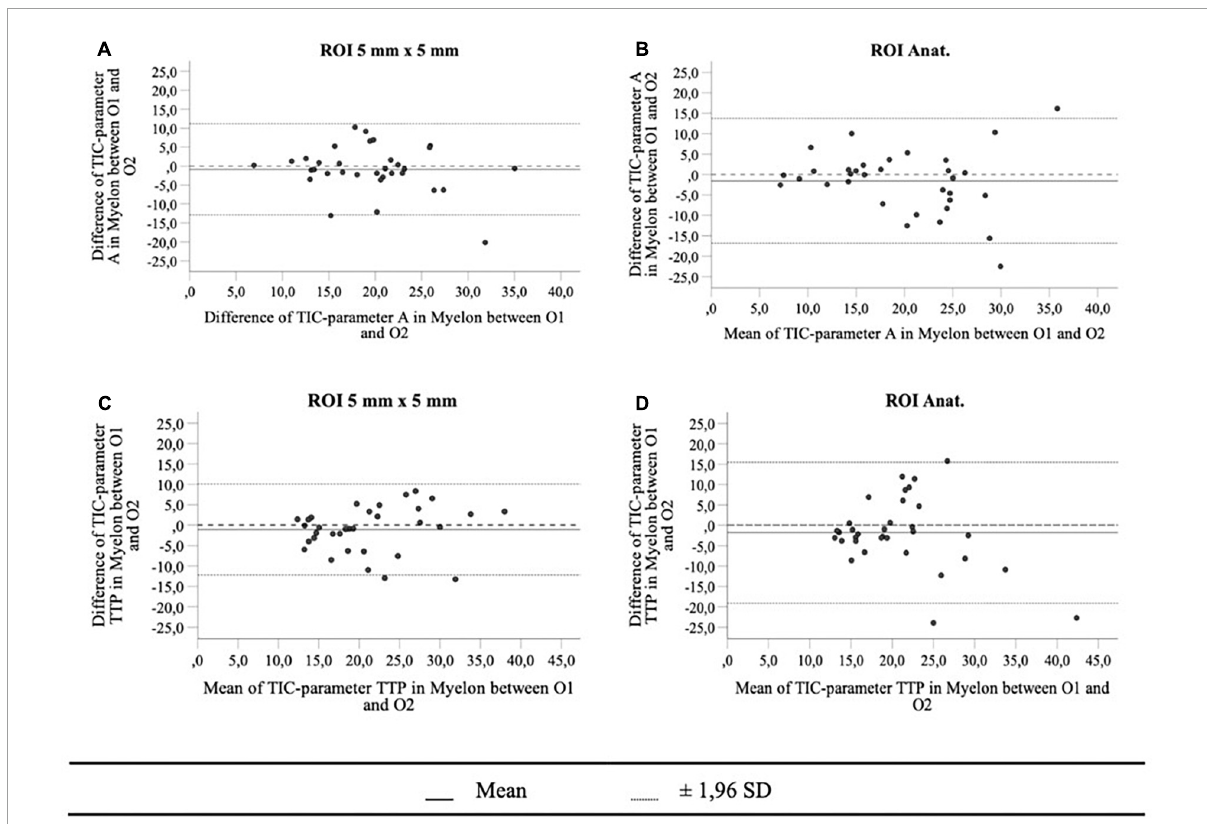
FIGURE4 The Bland-Altman plots for TIC parameters A (A,B) and TTP in myelon (C,D) show a greater level of agreement (mean ± 1,96 SD ) for method ROI Anat than for ROI 5 .